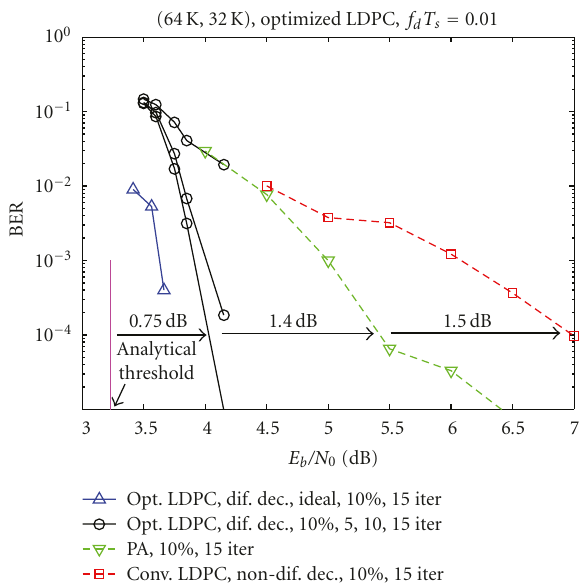
Figure 5: Simulations of optimized LDPC code with di ff erential coding and iterative di ff erential detection and decoding. Code rate 0.5037, normalized Doppler rate 0.01, 10% pilot insertion, degree profile λ ( x ) = 0 . 0672+0 . 4599 x +0 . 0264 x 8 +0 . 0495 x 9 +0 . 0720 x 10 + 0 . 0828 x 11 + 0 . 0855 x 12 + 0 . 0807 x 13 + 0 . 0760 x 14 , and ρ ( x ) = x 5 , 15 (global) iterations each with 6 (local) iterations in the outer LDPC